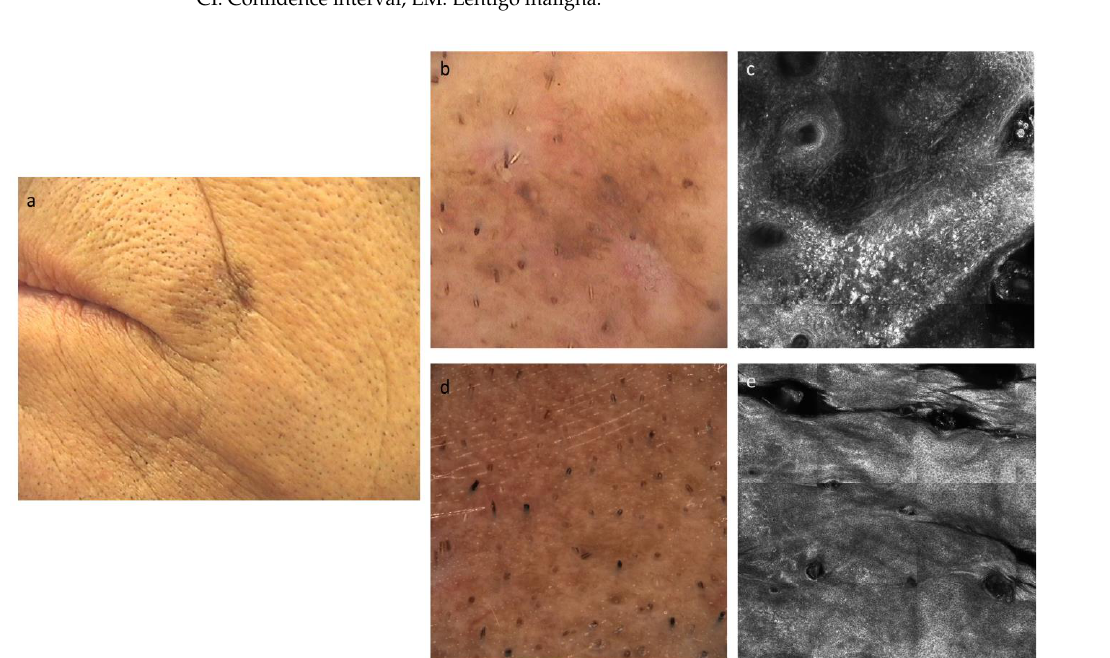
Figure 2. Kaplan – Meier plot of disease-free survival.